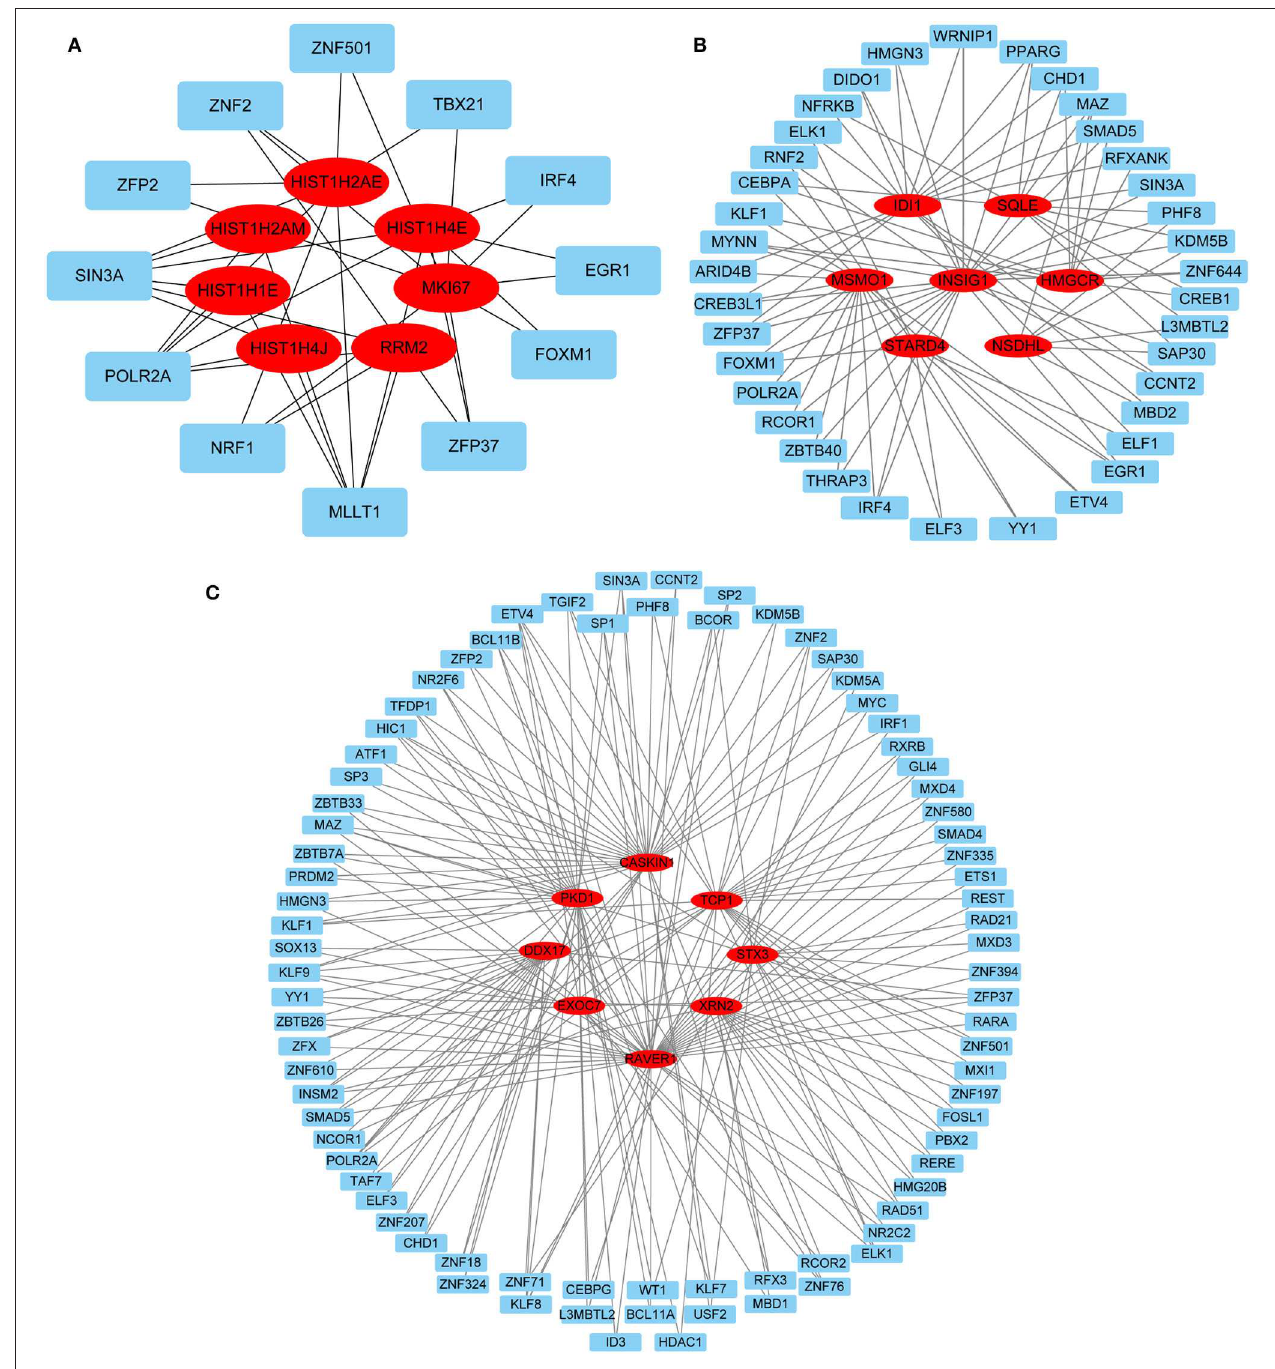
FIGURE 9 | TF-gene regulatory network. (A) Early stage (5h); (B) late stage (24h); (C) common stage. The background colors of genes and miRNAs are red and light blue, respectively. The sole connection of the TF-gene is hidden. TF, transcriptional factor.